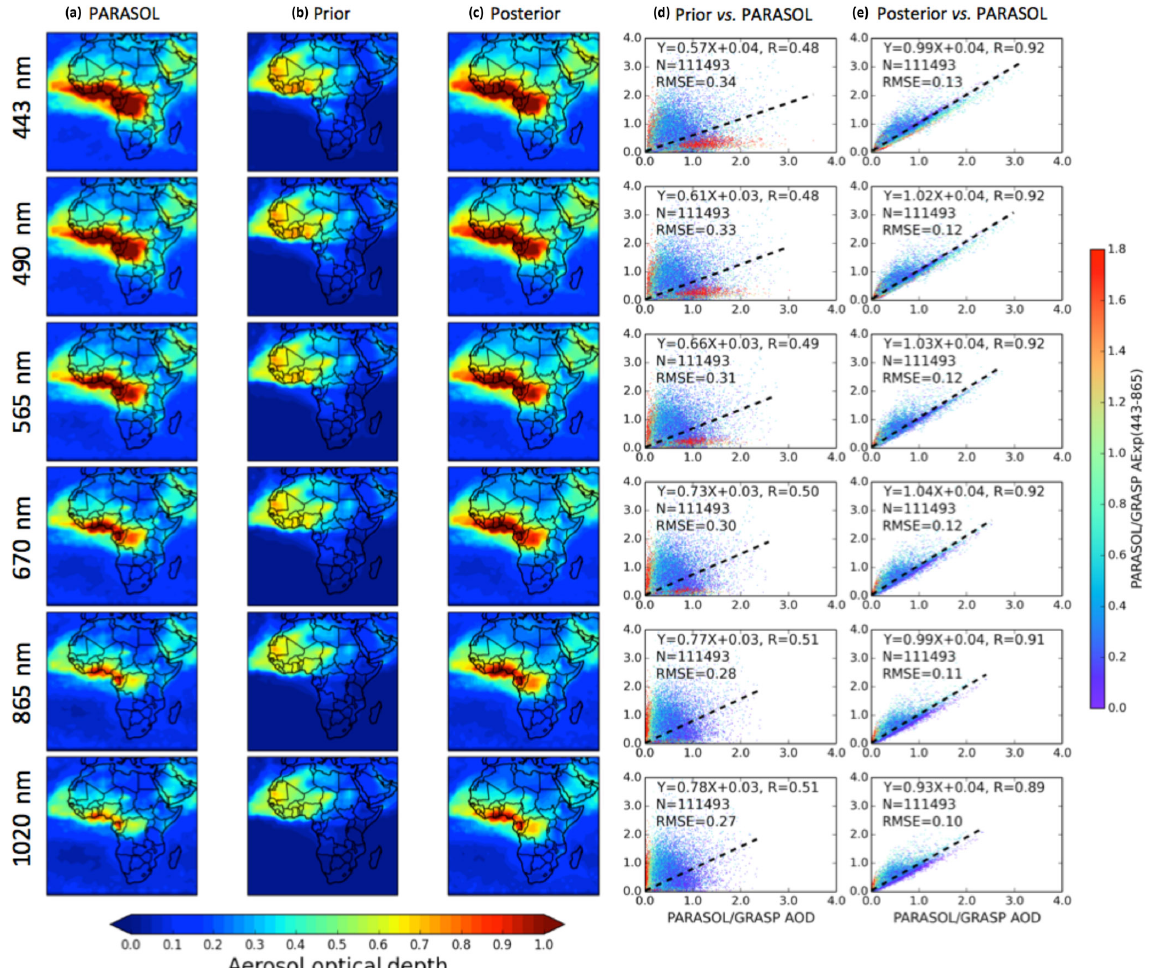
Figure 11. Comparison of the annual spatial distribution of prior (b) and posterior (c) GEOS-Chem-simulated AOD at 443, 490, 565, 670 865 and 1020nm with PARASOL/GRASP observations (a) . The posterior spectral AODs are simulated using retrieved DD, BC and OC emissions. The scatter plots are grid-to-grid comparisons between PARASOL/GRASP spectral observations versus prior (d) and posterior (e) GEOS-Chem simulations during 1 year. The correlation coefficient ( R ) and root-mean-square error (RMSE) are provided in the top left